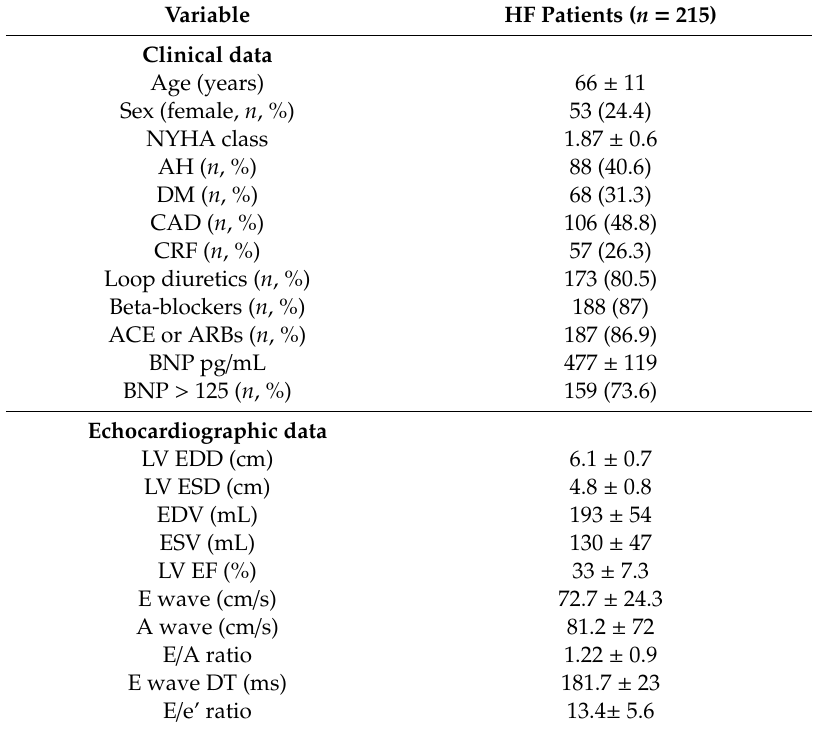
Figure A1. Measurement of LASt. Table A1. Baseline clinical, demographic and echocardiographic characteristics of patients.